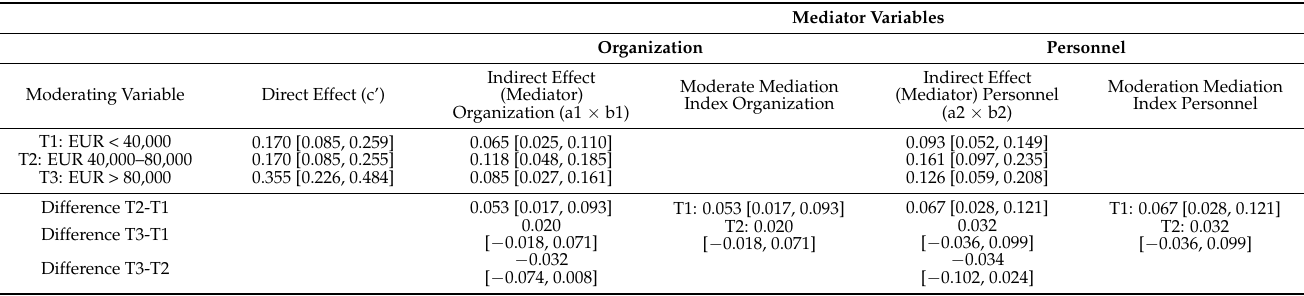
Unstandardized regression coefficients and 95% confidence intervals are reported. Direct effect: facilities -> satisfaction in the presence of mediators. Indirect effect: (facilities -> mediator) × (mediator -> satisfaction). Moderate mediation index: difference between the conditional indirect effects (for each of the income levels). Finally, Table 9 presents the results of the current research’s